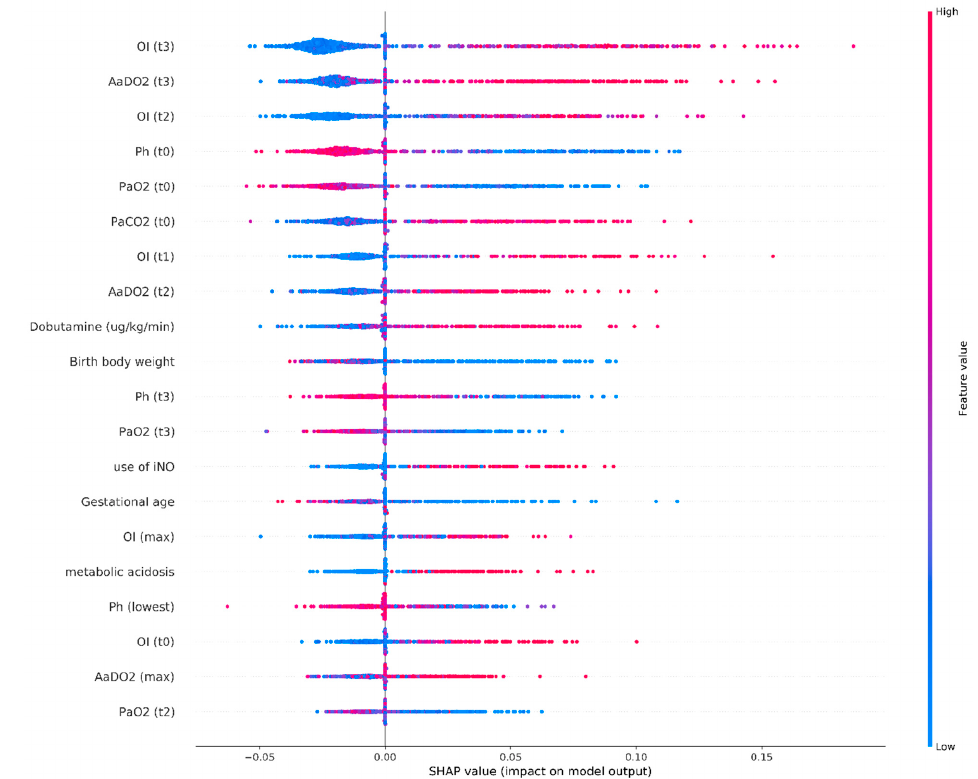
Figure 5. SHAP summary plot of the top 20 features of the RF model. The higher the SHAP value of a feature, the higher the probability of mortality in NICU patients with respiratory failure. Each dot is made up of each feature attribution value to the model of each patient. Red dots and blue dots represent higher feature values and lower feature values, respectively. Abbreviations: OI: oxygenation index; AaDO2: alveolar–arterial oxygen tension difference.